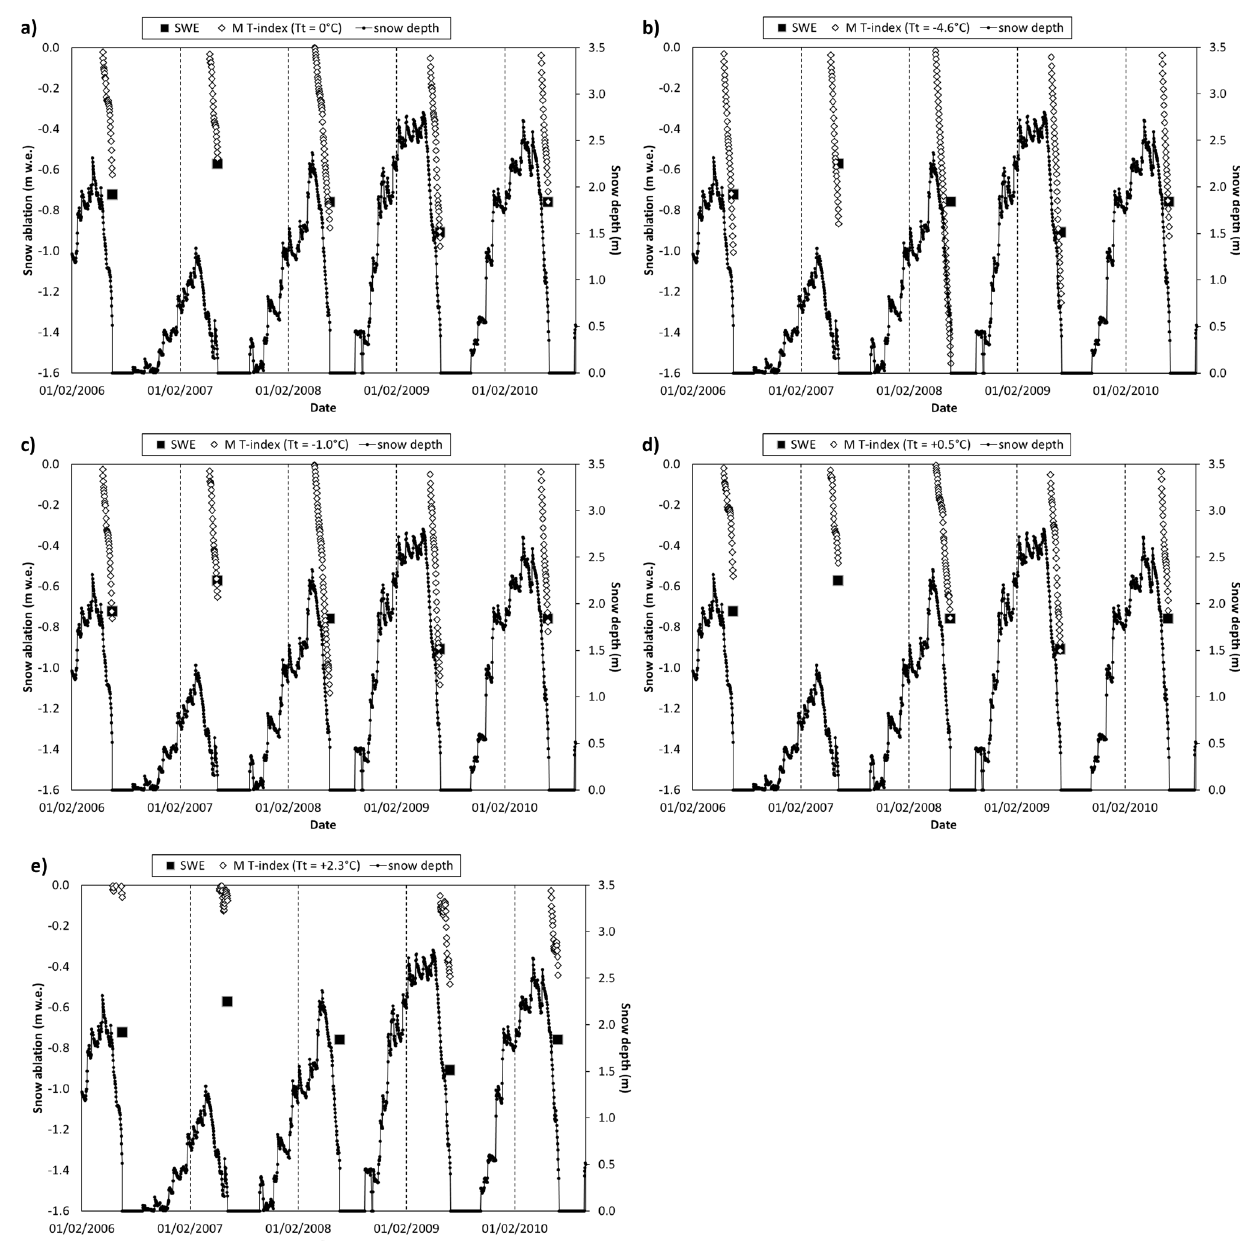
Figure 5. Comparison between snow ablation measured by sonic ranger (SWE) and estimated by T -index approaches from 2006 to 2012. The results from the T -index model ( M T -INDEX ) were obtained by applying different temperature thresholds to T B data: 0 ◦ C (a) , − 4.6 ◦ C (b) , − 1.0 ◦ C (c) , + 0.5 ◦ C (d) and + 2.3 ◦ C (e) . The trend of the snow depth measured by sonic ranger is shown as